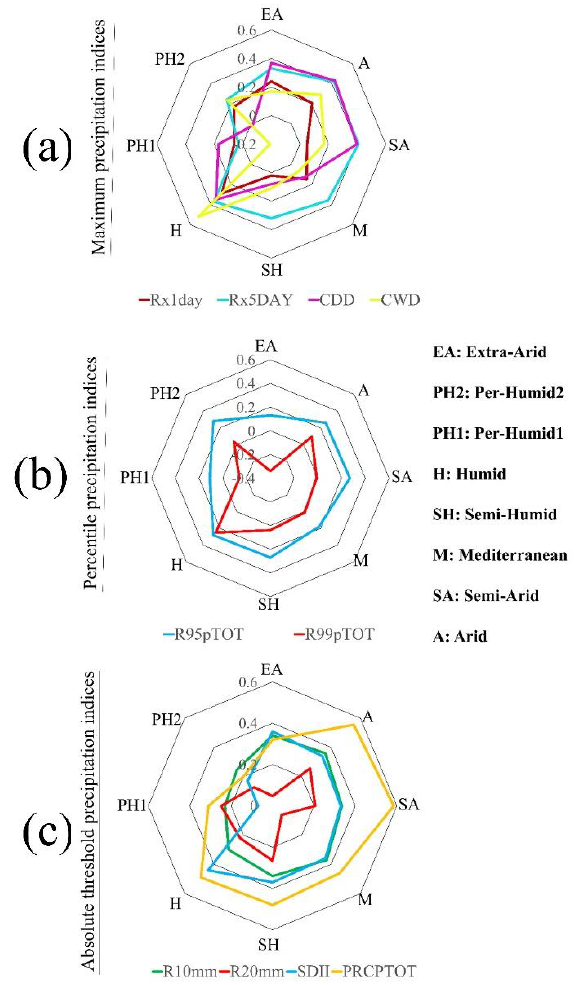
Figure 11. Summary of evaluations for all extreme precipitation indices over varying climate regions based on Kling-Gupta efficiency (KGE) index. ( a – c ) are representing maximum precipitation indices, percentile indices, and absolute threshold indices, respectively.